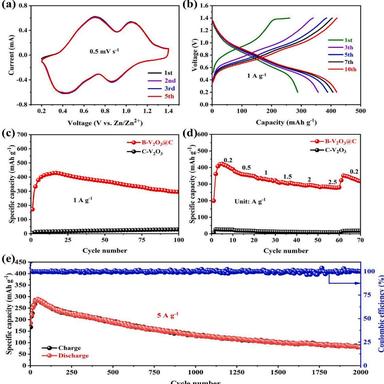
(a) CV profiles of B–V2O3@C (Scanning rate 0.5 mV s − 1 ). (b) Discharge-charge curves of B–V2O3@C. (c) Cycling capacity and (d) rate performance of B–V2O3@C and C–V2O3. (e) Long-cycling capacity of B–V2O3@C at the current density of 5.0 A g− 1 .